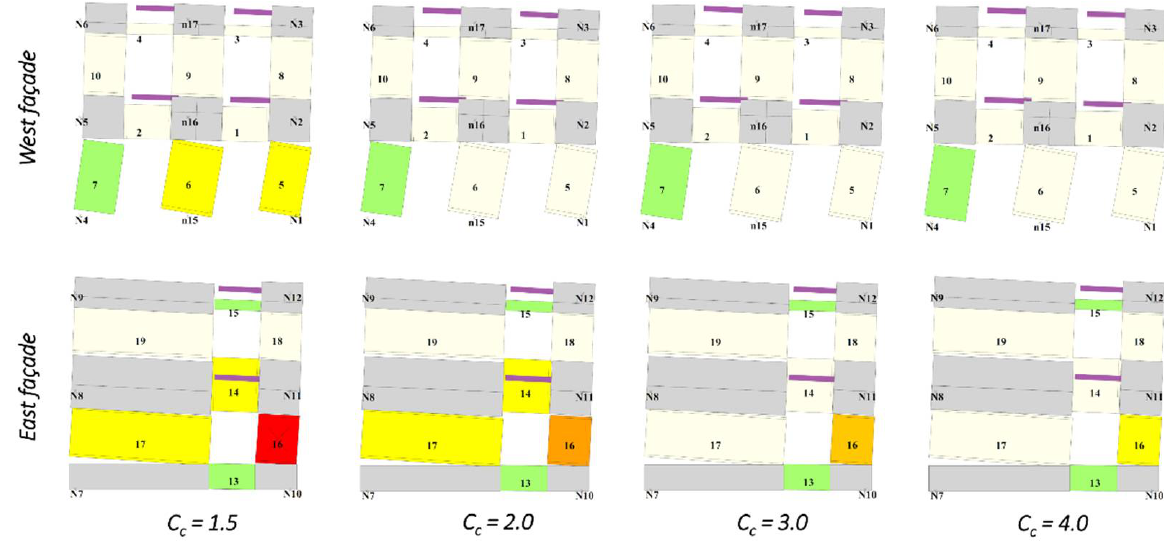
Figure 17. Comparison between damage patterns obtained with various correction coefficients for Building 2 neglecting any masonry tensile strength (with magnified lateral displacements).